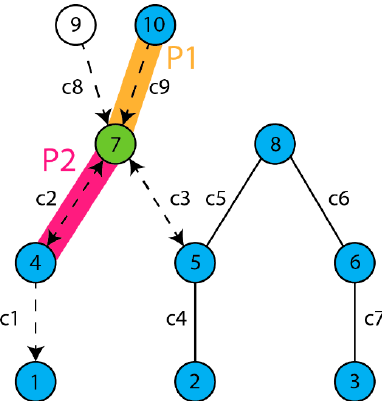
Figure 8. The two potential paths considered in this example are not the only one. They were selected to highlight the importance of the determination of interdependencies.